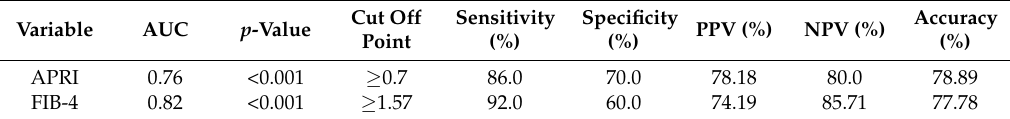
Table 3. Diagnostic performance of APRI and FIB-4 in hepatocellular carcinoma patients vs. cirrhotic patients and control group.